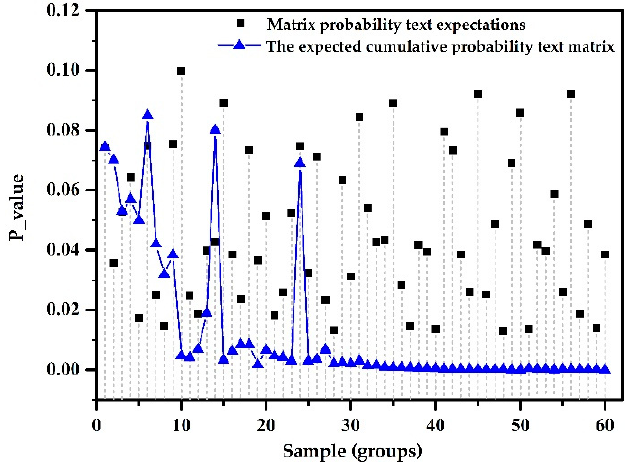
Figure 1. Organization superiority with reasonable verification.